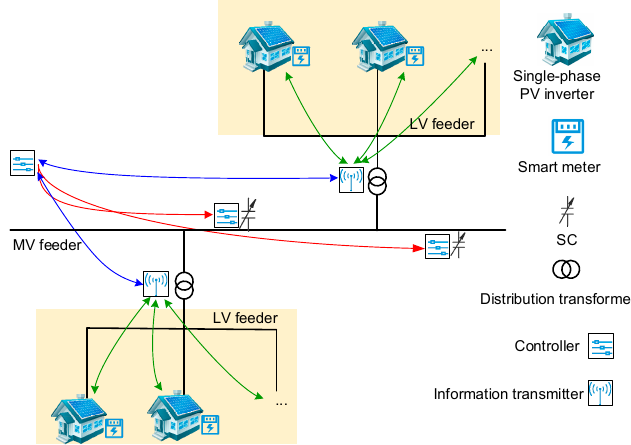
Figure 1. Schematic illustration of the key concept of this research.